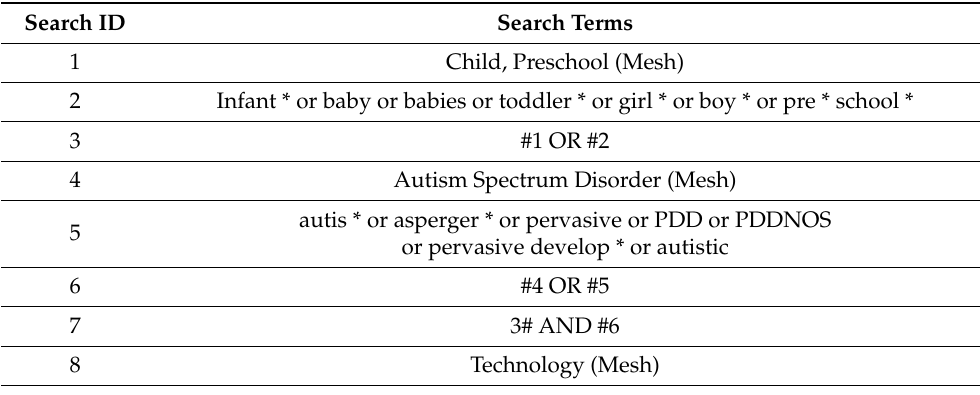
Table A1. PubMed search terms.